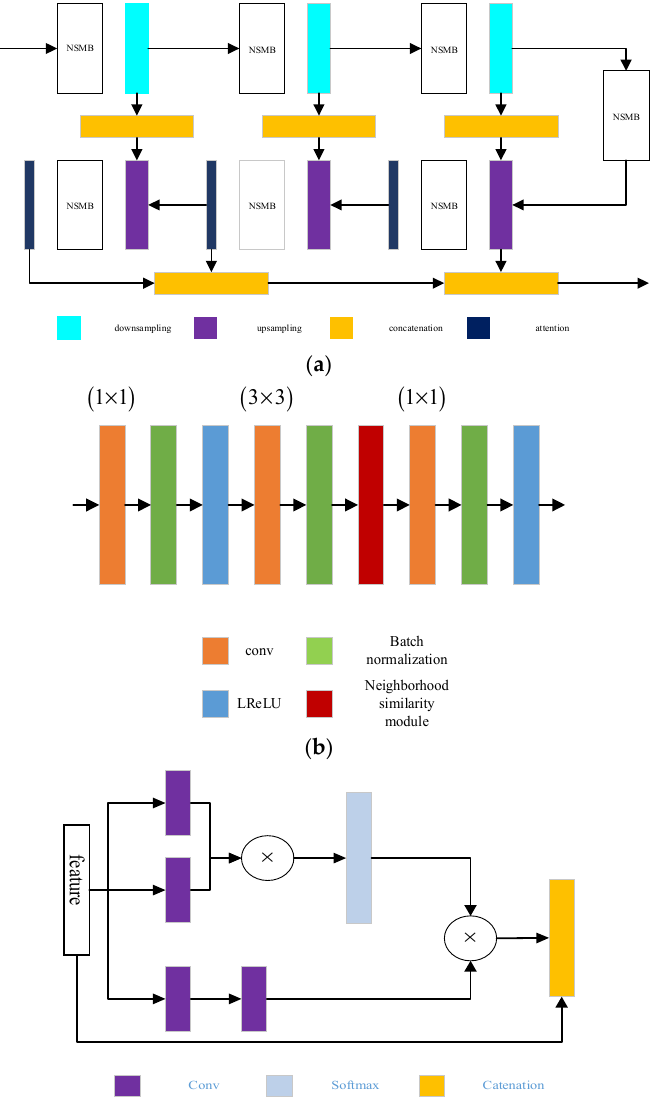
Figure 5. The detailed structure of our self-constructed network: ( a ) network structure; ( b ) NSMB module; ( c ) neighborhood similarity module.